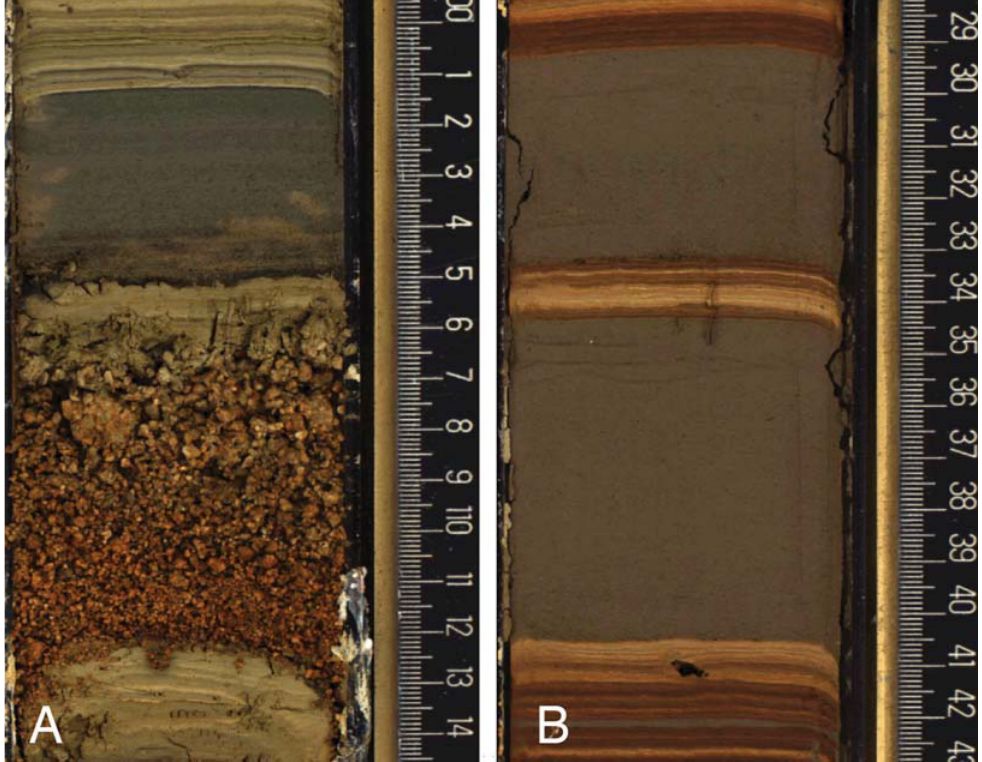
Figure 12. [A] A coarse volcaniclastic layer and a turbidite layer interrupting the continuous, laminated background sedimentation at the Ahlat Ridge site. Note the inverse grading of the pumice particles (deposition from a pumice raft). [B] Two turbidite layers interrupting the laminated sequences (Northern Basin site) consisting mostly of reworked volcaniclastic